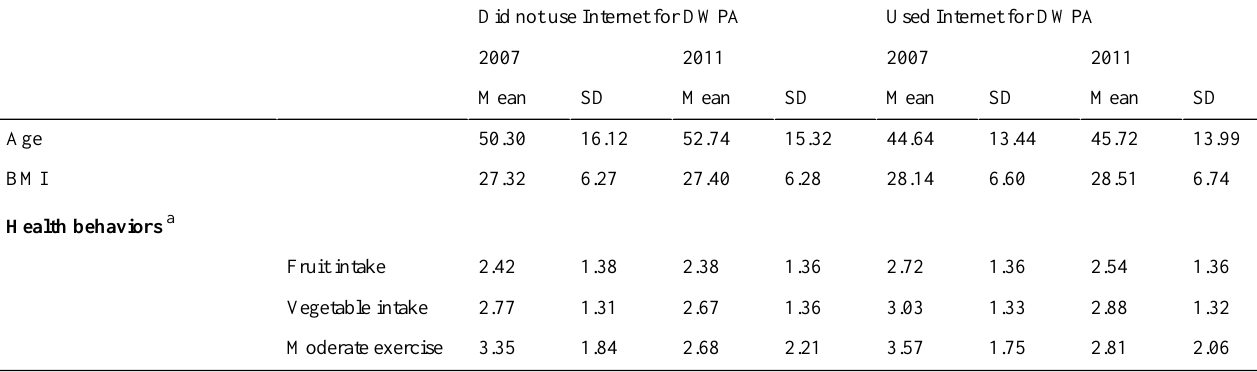
Table 2. Demographic and health behavior correlates of using the Internet for help with DWPA in 2007 and 2011.